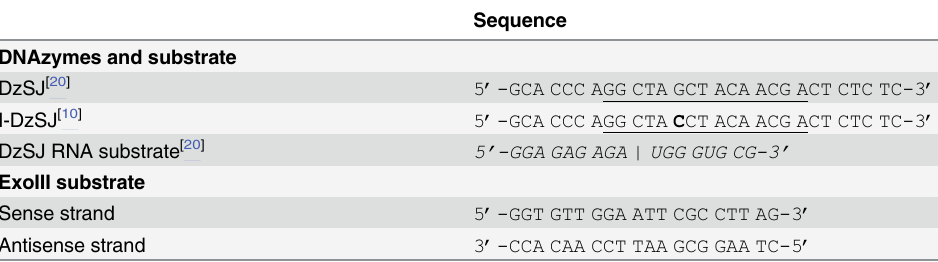
Table 1. Sequences of oligonucleotides.